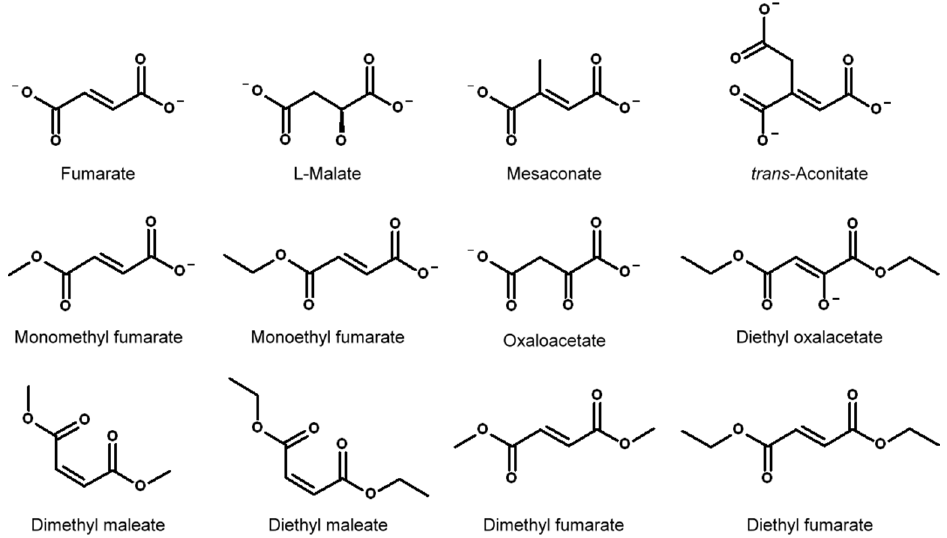
Figure 1. Chemical structures of fumarate and its analogs. These structures were generated using Accelrys Draw (Accelrys, USA).